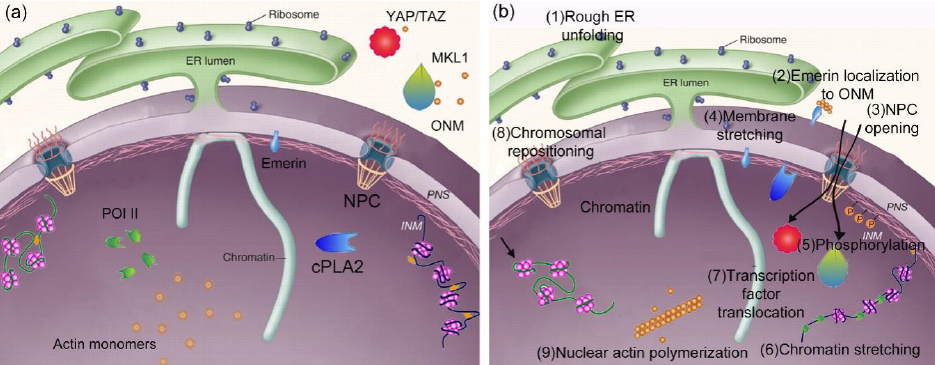
Figure 8. Schematic diagram of the mechanism of nuclear response to mechanical stimulation. ( a ) Under normal conditions, the internal and external environment of the nucleus. ( b ) After mechanical